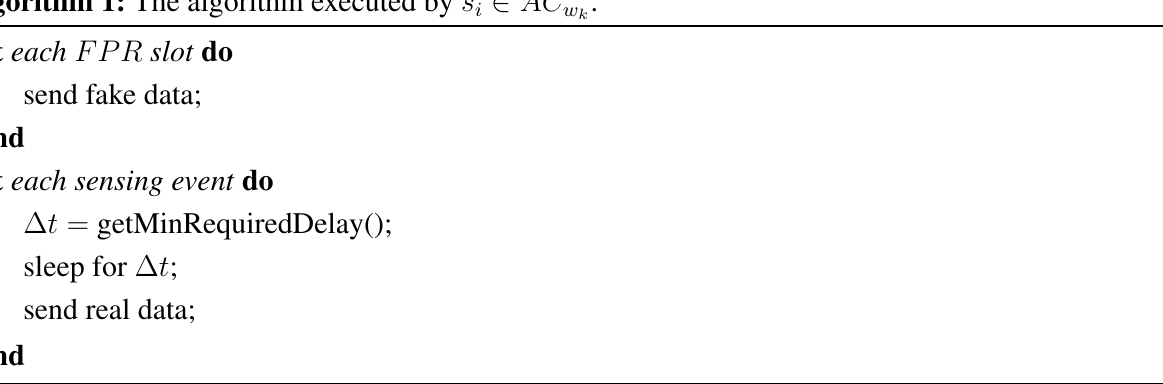
Algorithm 1: The algorithm executed by s